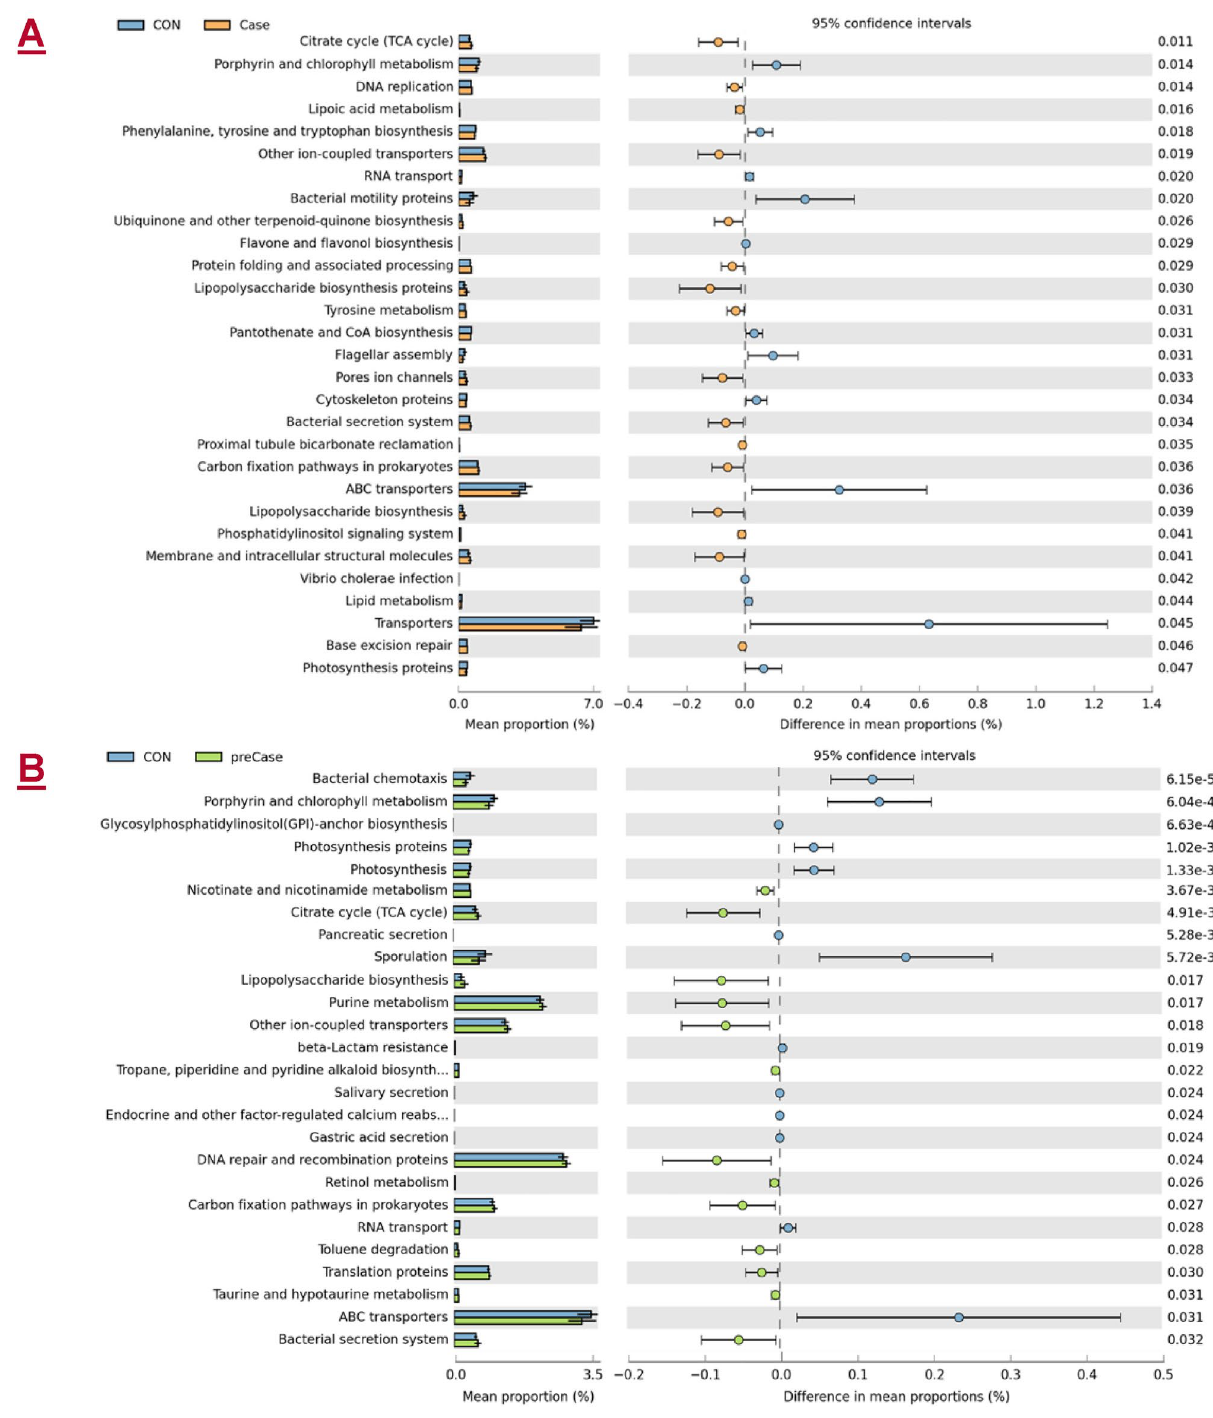
Figure 6. Selected pathways predicted by PICRUSt functional classification of the metagenome content of the microbiota in ( A ) sarcopenic (Case; yellow) and ( B ) possibly sarcopenic (preCase) versus healthy control (CON; blue) subjects. Welch’s